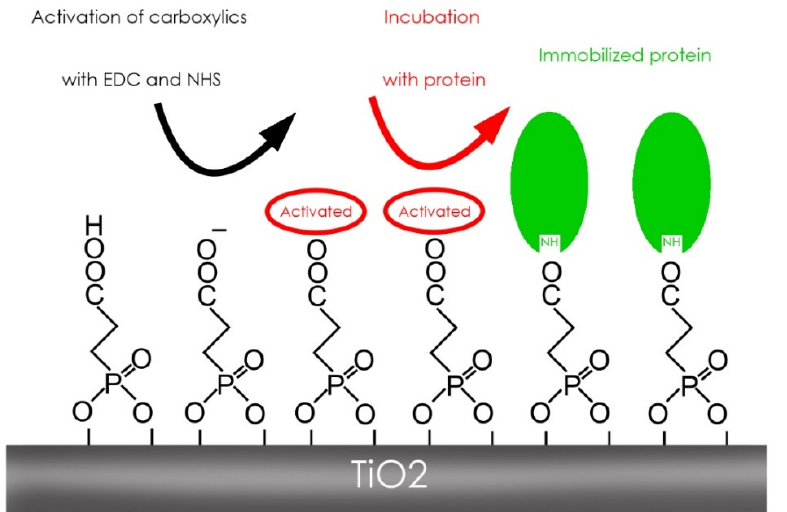
Figure 2. Scheme of the binding process from activation of carboxyl groups, incubation with the protein, and immobilization of the